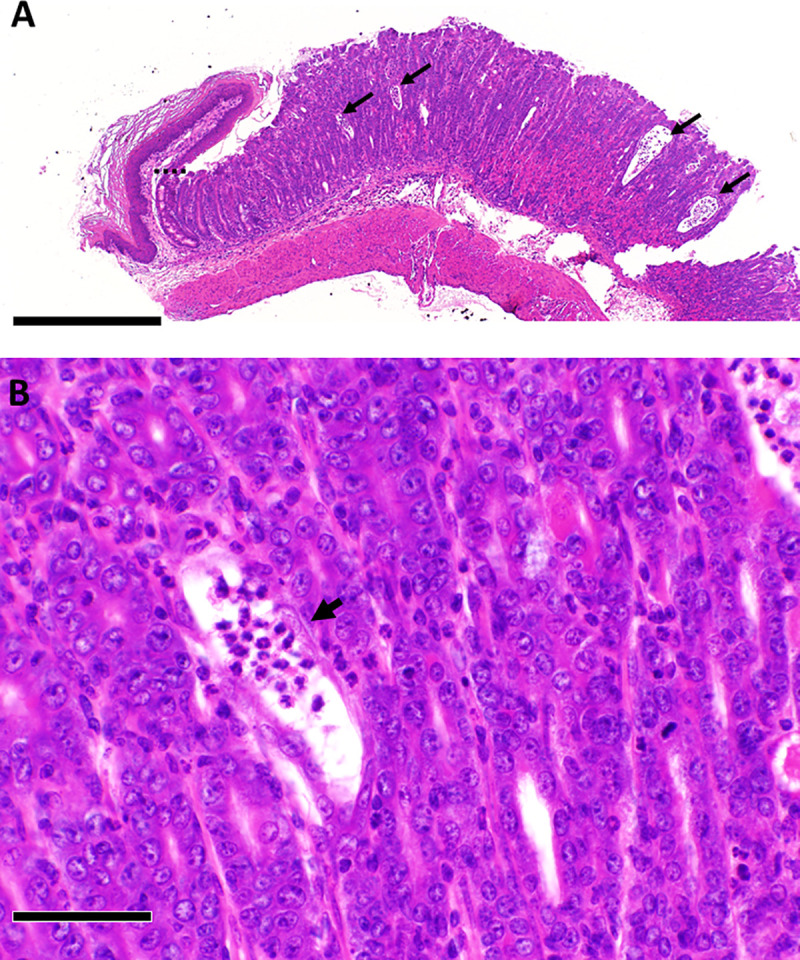
Stomach inflammation in TIA mice.The dashed line in A represents the boundary between the forestomach and the glandular stomach. A higher magnification view in B shows inflamed gastric glands that resemble crypt abscesses, with thinning of glandular epithelium and neutrophils present within the dilated lumens, as indicated by arrows. Scale bar represents 500 μm in A and 50 μm in B.